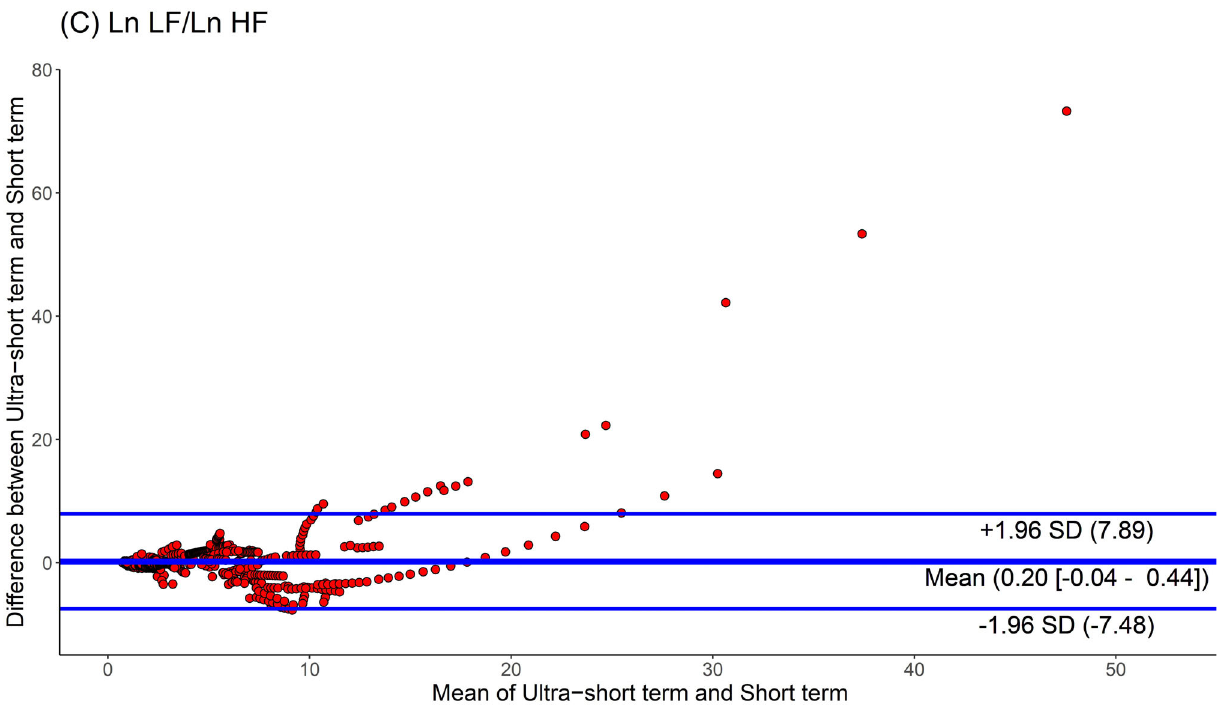
Figure 4. Agreement rate of heart rate variability parameters between ultra-short- and short-term methodology using Bland-Altman plots: ( A ) Ln LF, ( B ) Ln HF, ( C ) Ln LF/Ln HF (standard deviation, SD; low frequency, Ln LF; high frequency, Ln HF).